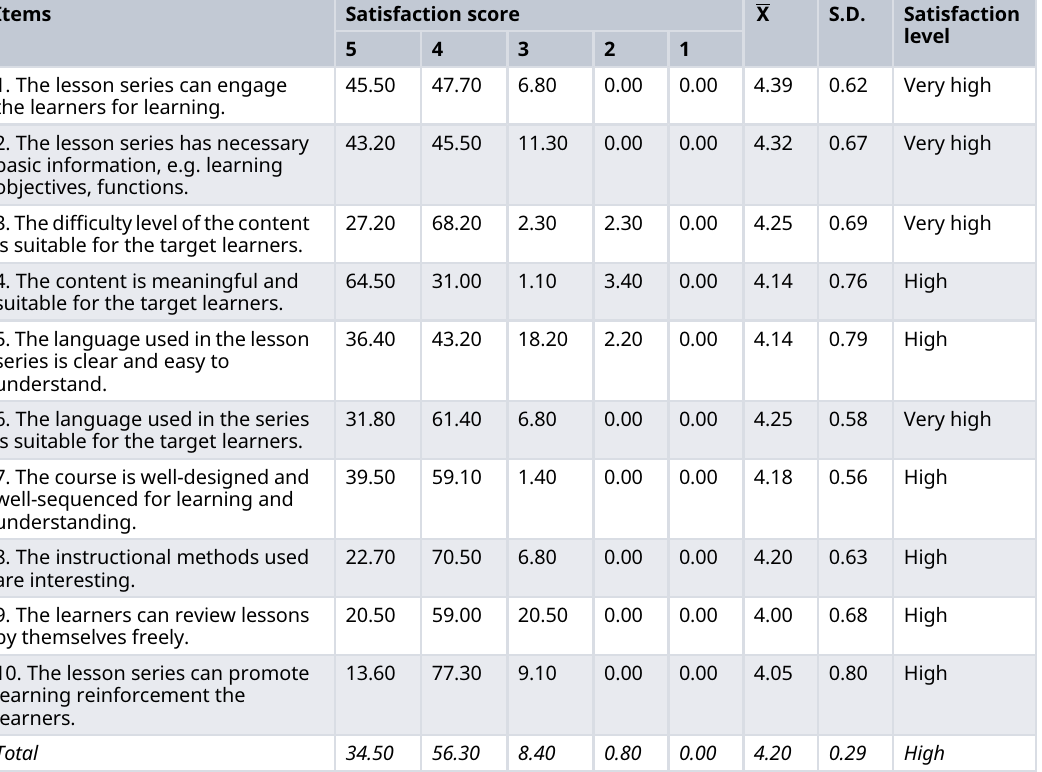
Table 3. CAIFLS satisfaction of the experimental group.